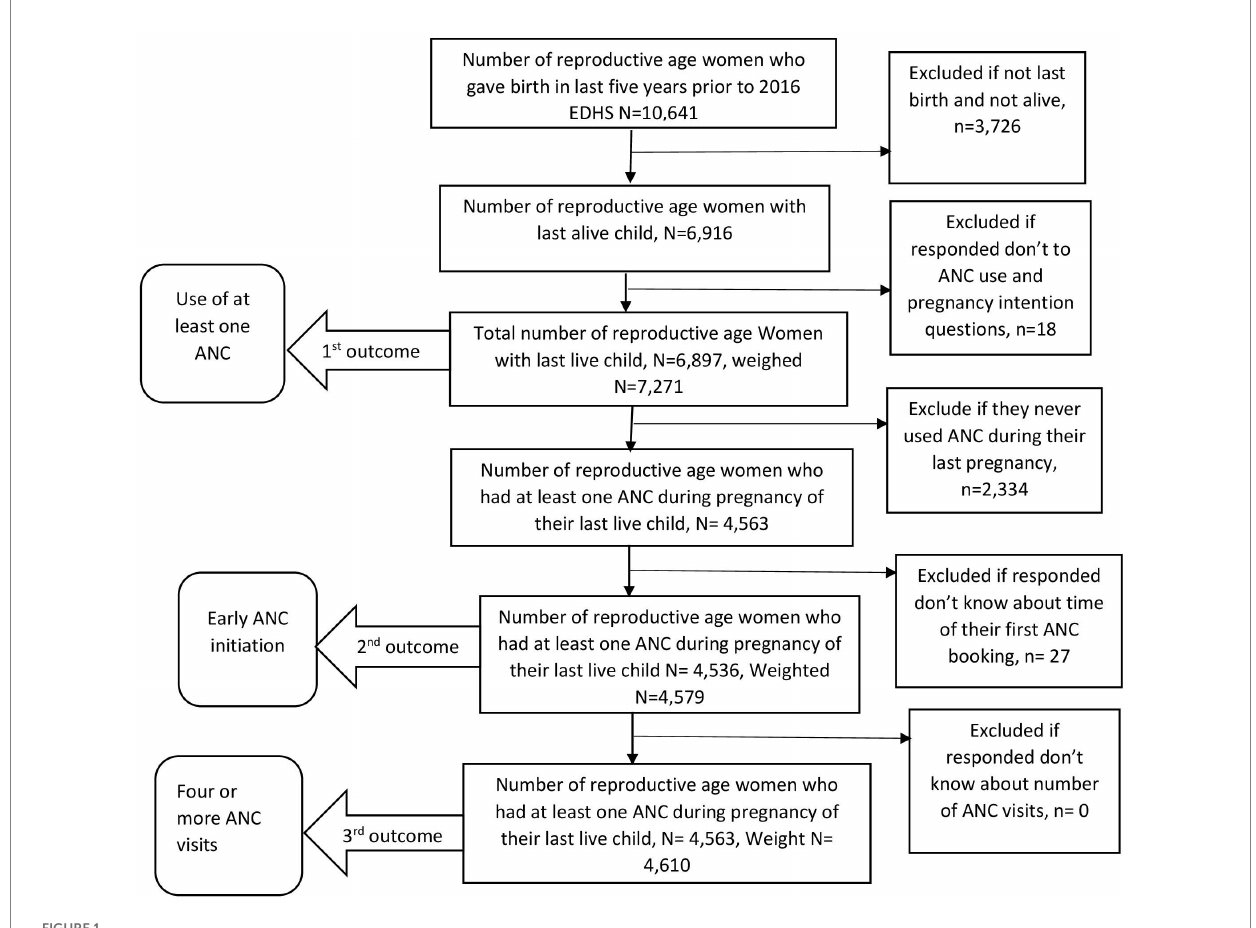
FIGURE 1 Population flow diagram (weighted number of cases for each